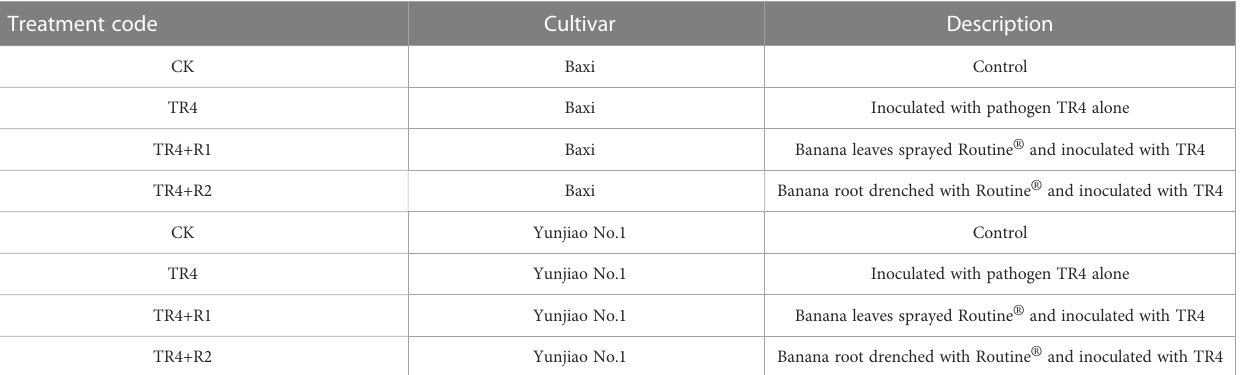
TABLE 1 Different treatments in pot